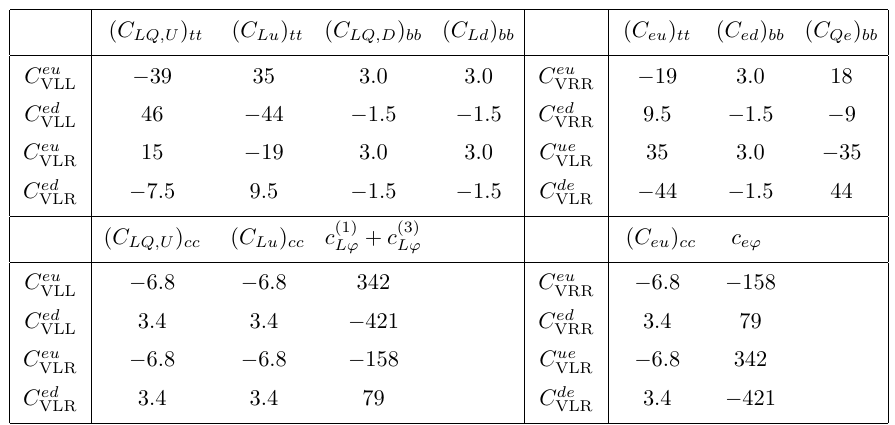
Table 23 . The Wilson coefficients (in units of 10 − 3 ) at µ = 2 GeV induced by nonzero top-, bottom- and charm-quark vector-like operators at the scale Λ = 1 TeV, and by Z CLFV vector and axial couplings. The u -type operators have flavor indices uu , while the d -type dd or ss .